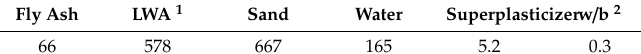
Table 1. Fiber addition of lightweight aggregate concrete (LWAC) mixtures.